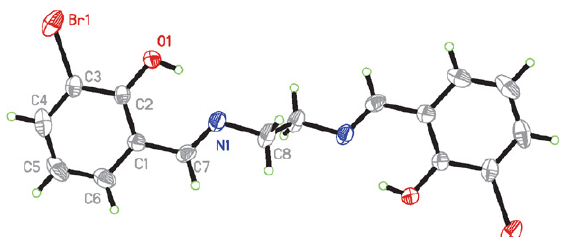
Fig. 1. Molecular structure of H 2 L with thermal ellipsoids of 30% probability